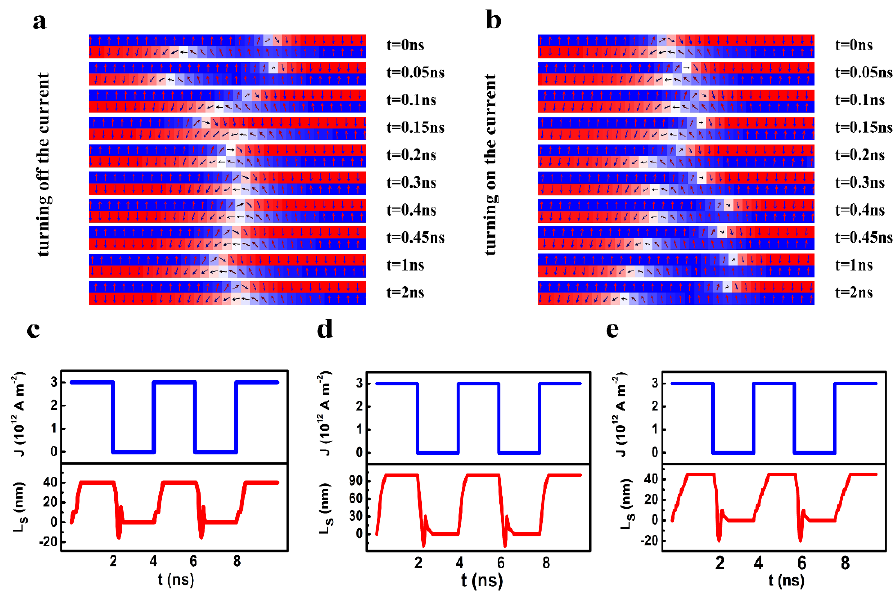
Figure 8. The snapshots of the decaying oscillation of the staggered domain region ( a ) after turning off the current and ( b ) after turning on the current (α = 0.1, J ex = −0.2 × 10 −3 J/m 2 , D = 0.25 mJ/m 2 , K up = 6 × 10 5 J/m 3 , K low = 2.5 × 10 5 J/m 3 ), ( c–e ). the evolution of the L s with the injection of the current pulse under different magnetic parameters (( c ): α = 0.1, J ex = −0.2×10 −3 J/m 2 , D = 0.25 mJ/m 2 , K up = 6 × 10 5 J/m 3 , K low = 2.5 × 10 5 J/m 3 , ( d ): α = 0.1, J ex = −0.15 × 10 −3 J/m 2 , D = 0.75 mJ/m 2 , K up = 6 × 10 5 J/m 3 , K low = 2.5 × 10 5 J/m 3 , ( e ): α = 0.1, J ex = −0.2 × 10 −3 J/m 2 , D = 0.75 mJ/m 2 , K up = 4 × 10 5 J/m 3 , K low =2.5 × 10 5 J/m 3 ).